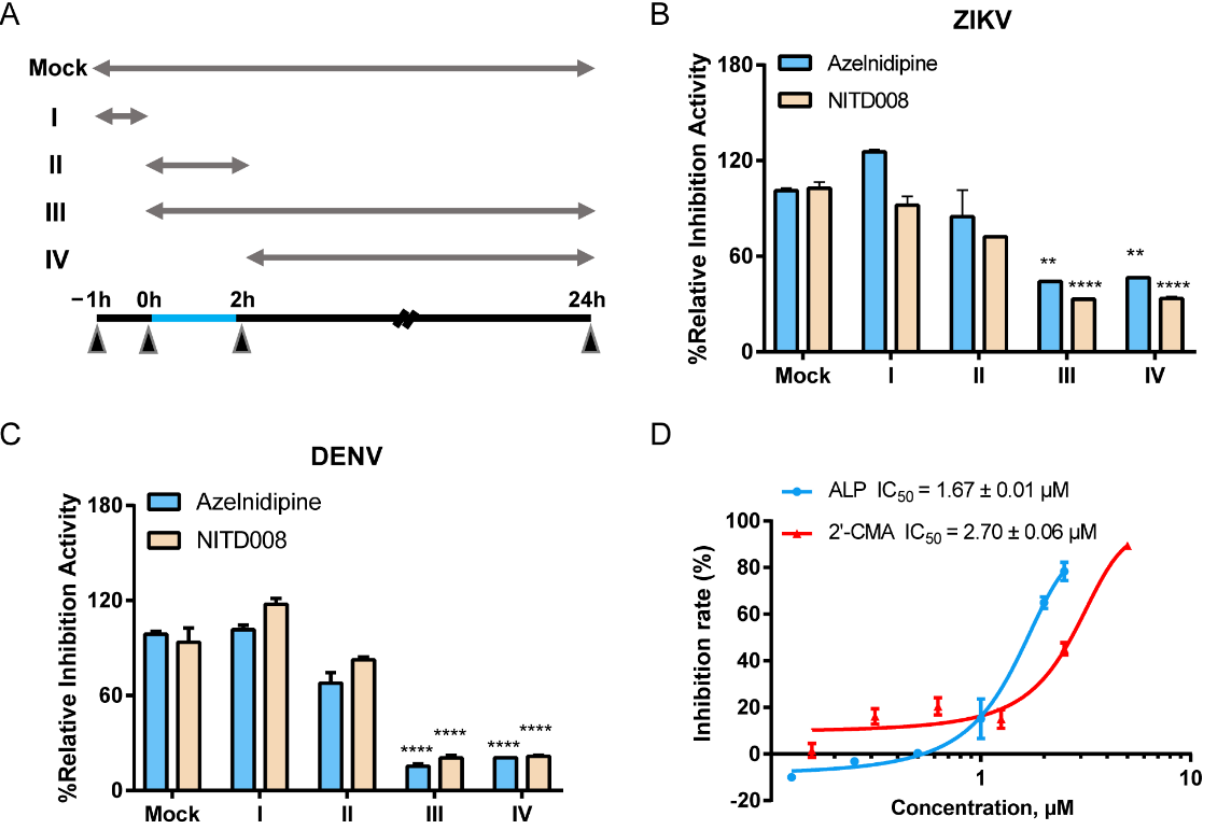
Figure 2. Time-of-drug-addition assay and the replicon assay for ALP. ( A ) Experimental design of the time-of-drug-addition assay. Virus diluent (blue line) was incubated with the cells at 0–2 h. ALP and the positive control drug NITD008 were added to the cells before, during, after, or throughout the whole infection, respectively, as indicated in the horizontal upper lines. The cellular RNA was extracted at 24 h.p.i. and quantitated by qRT-PCR. One-way analysis of variance ( B , C ) was performed for statistical analysis. Data are expressed as means ± standard error of mean. ** p < 0.01 and **** p < 0.0001. ( D ) The inhibitory effect of ALP against ZIKV replicon. Cells were treated with ALP at the indicated concentrations, and luciferase activities were measured at 48 h.p.i. The inhibitor 2′ -CMA was set as the positive control. The inhibition curve was fitted using GraphPad Prism 7 software.